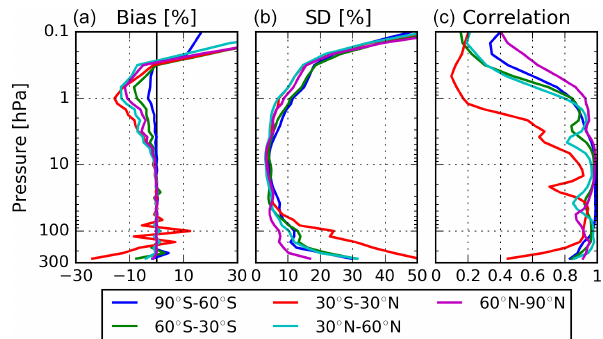
Figure 2. Forecast minus observation (FmO) statistic profiles be- tween NR and the assimilated MLS data in five latitude bands (see legend) for the period June–October 2009. (a) Bias (or mean dif- ference) between NR and MLS. (b) The standard deviation of the differences. (c) The sample correlation coefficients between NR and MLS. Differences are shown in percentage and are normalized by the mean of